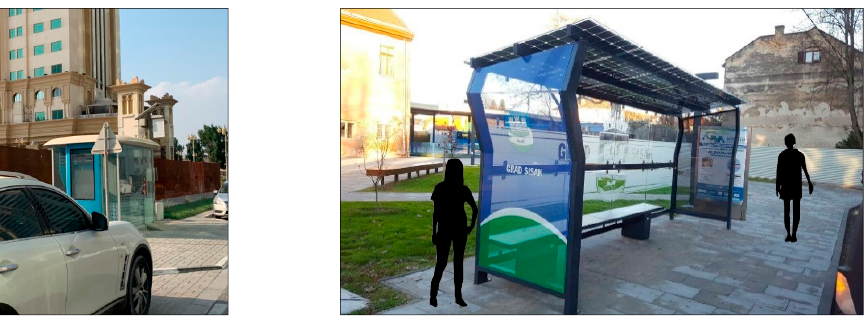
Figure 29. ( left ) Bus stop in West Bay with solar panel (source: the Authors); ( right ) bus stop with solar roof, recommended for the study site (Source: Yeroo Group. Adapted from [42]).